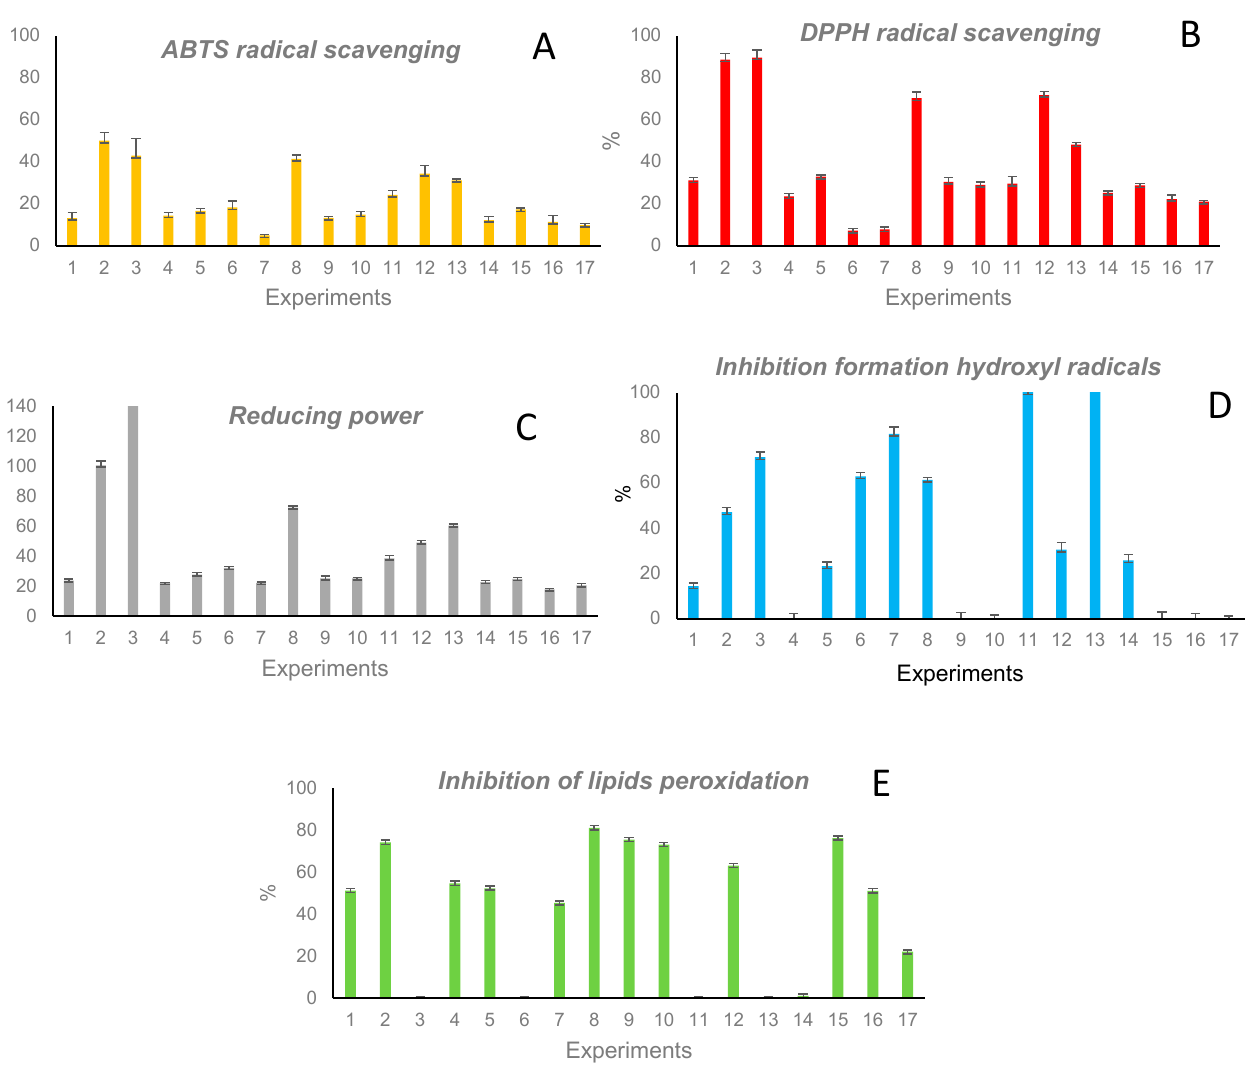
Figure 1. Capacity to scavenge ABTS ( A ) and DPPH ( B ) radicals, to reduce oxidant compounds ( C ), to inhibit the formation of hydroxyl radicals ( D ), and to inhibit lipids peroxidation ( E ) of the 17 extracts obtained by PLE.